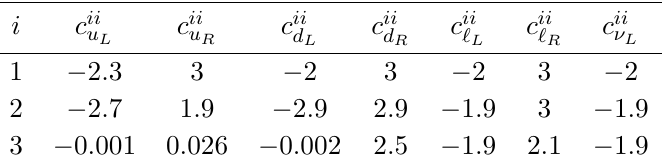
Table 2 . The (cid:13)avor diagonal couplings of Z 0 to the SM fermions, eq. (5.10), for the G FN = U(1) FN benchmark. For a complete list see appendix